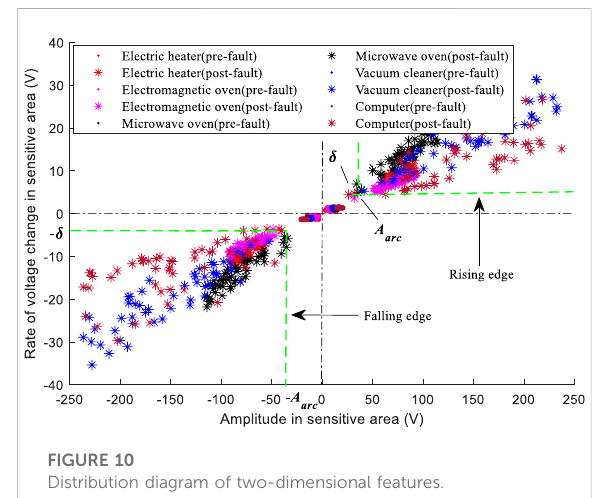
FIGURE 10 Distribution diagram of two-dimensional